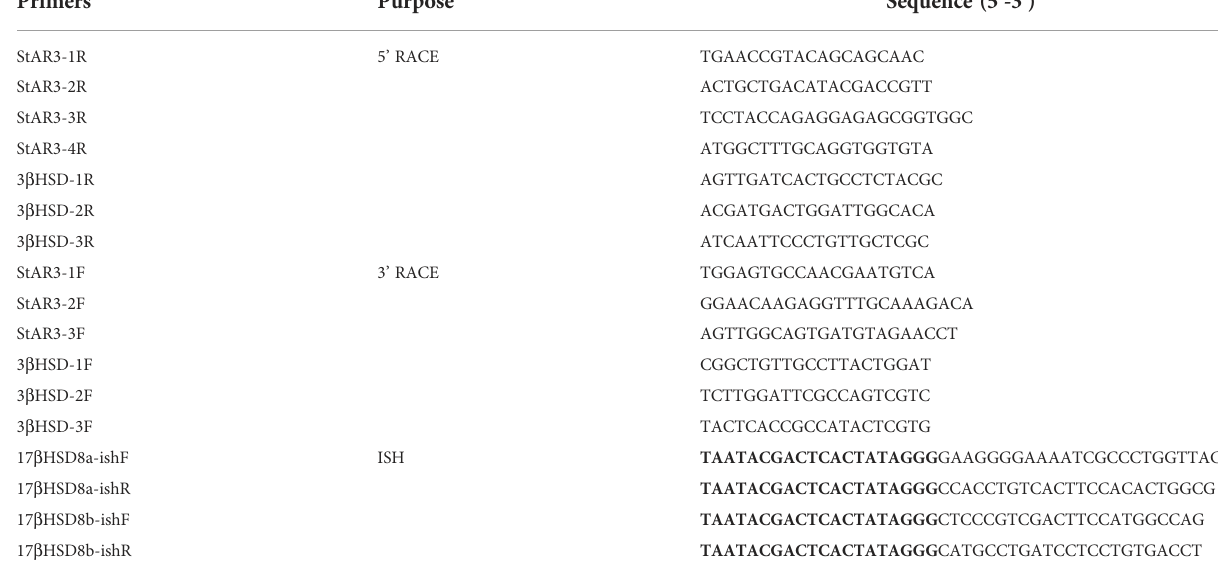
TABLE 1 List of primers that were used for 5 ′ and 3 ′ RACE, and in situ hybridization.